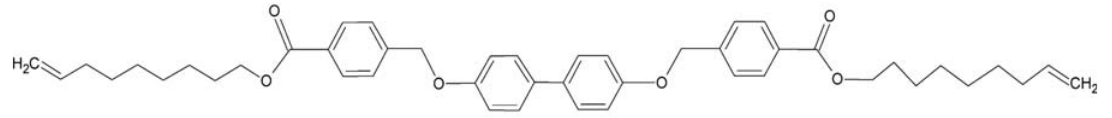
Scheme 1. Molecular structure of the crosslinker, labelled ‘C’.